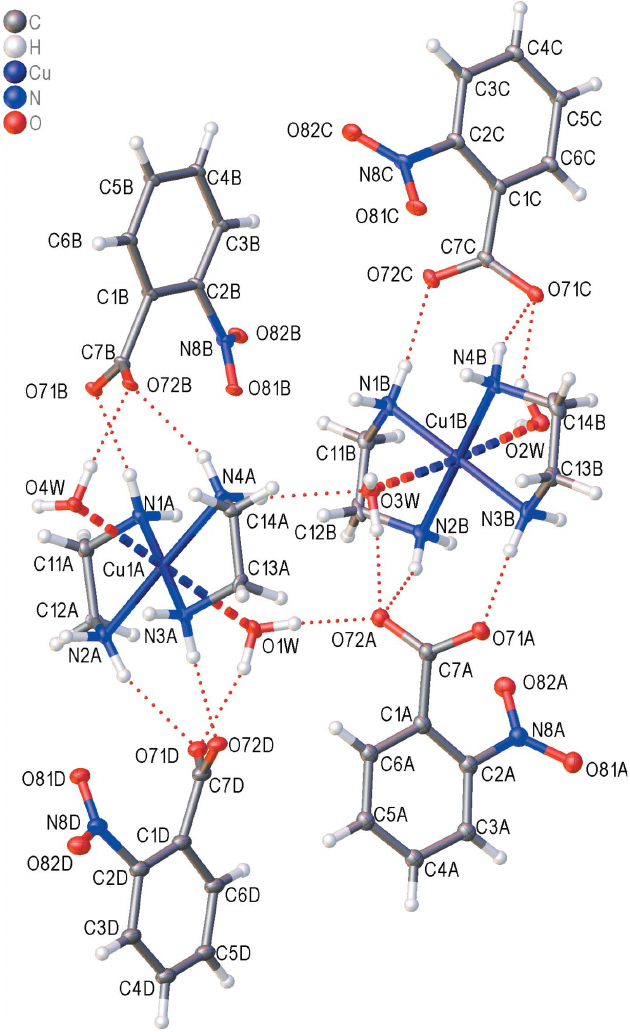
Figure 1 The asymmetric unit of the title complex, showing the major component of the disorder only, with the atom labeling. Displacement ellipsoids are drawn at the 50% probability level.